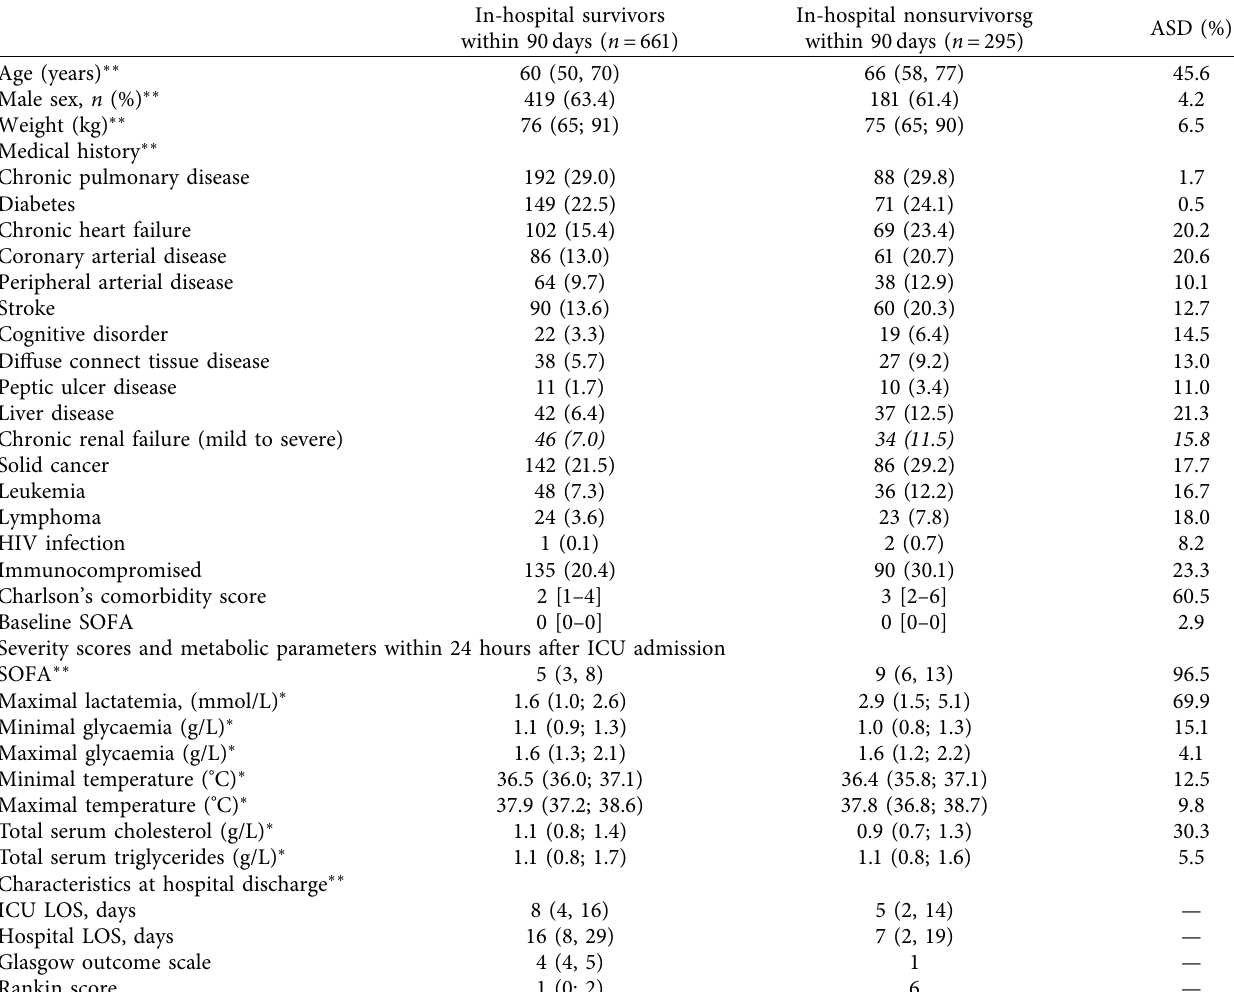
Table 1: Main characteristics of hospital survivors and nonsurvivors to infections at 90 days.